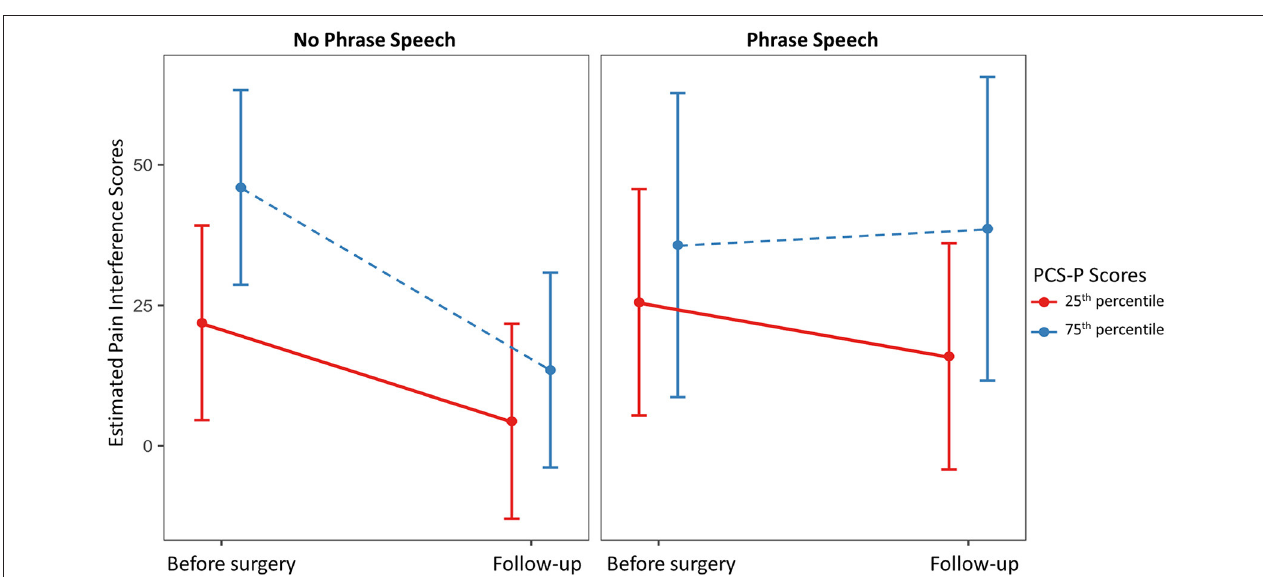
FIGURE 1 | Estimated marginal mean pain interference scores at the 25 th and 75 th percentile scores on the Pain Catastrophizing Scale for Parents (PCS-P) by child spoken language ability prior to surgery and at follow-up.